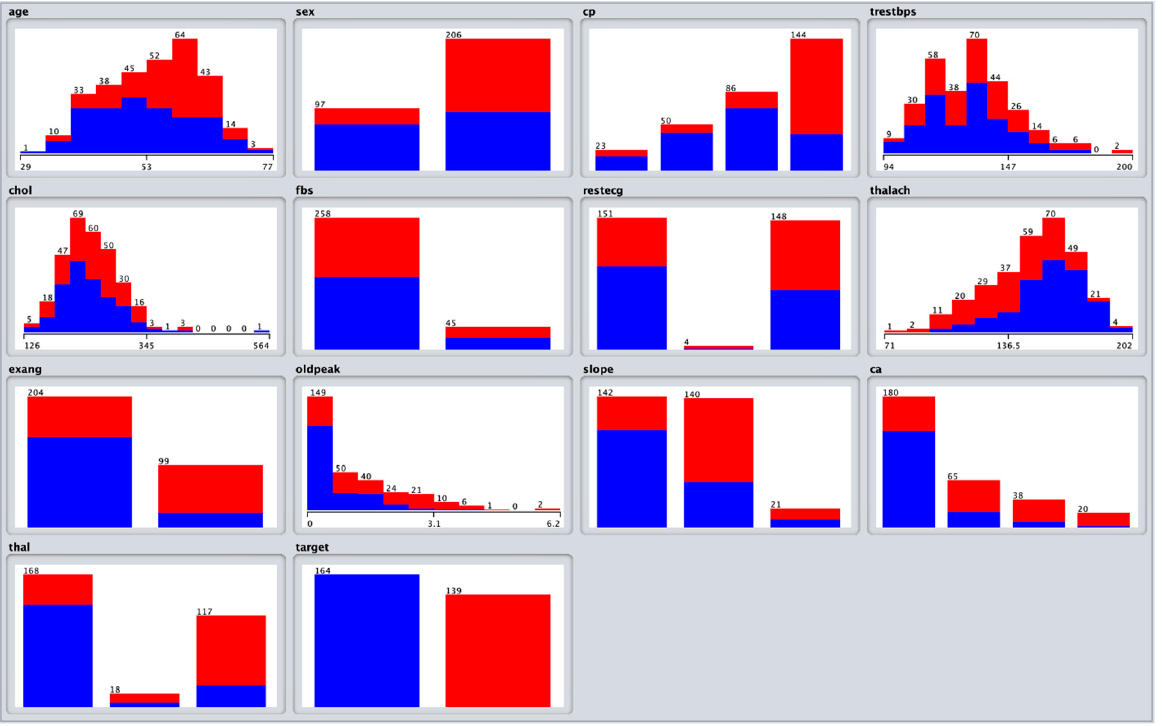
Figure 2. Visualization of attributes of the Cleveland heart dataset.